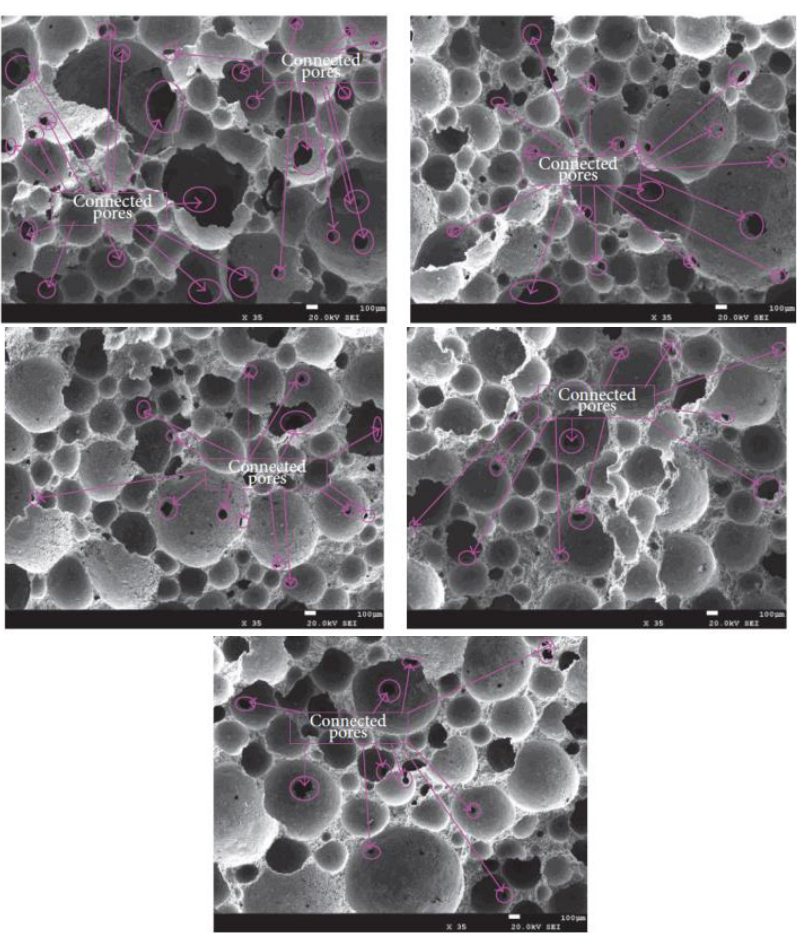
Figure 4. The effect of change in w/c ratio on pore structure Figure 4 . The effect of change in w/c ratio on pore structure [72].